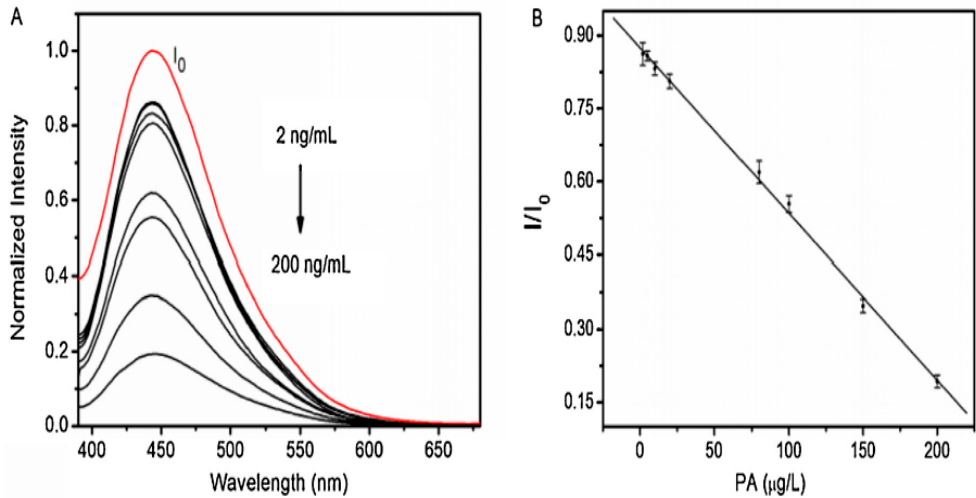
Figure 2. ( A ) Fluorescence emission spectra of BSA/creatinine/N-GQDs–chitosan solid film in the presence of PA at 0 (red line I0), 2, 5, 10, 20, 80, 100, 150 and 200 ng/mL (from top to bottom). ( B ) Stern–Volmer curve. I and I0 were the fluorescence intensities of BSA/creatinine/N-GQDs–chitosan fluorescent solid film at 360 nm in the presence and absence of PA, respectively [57].